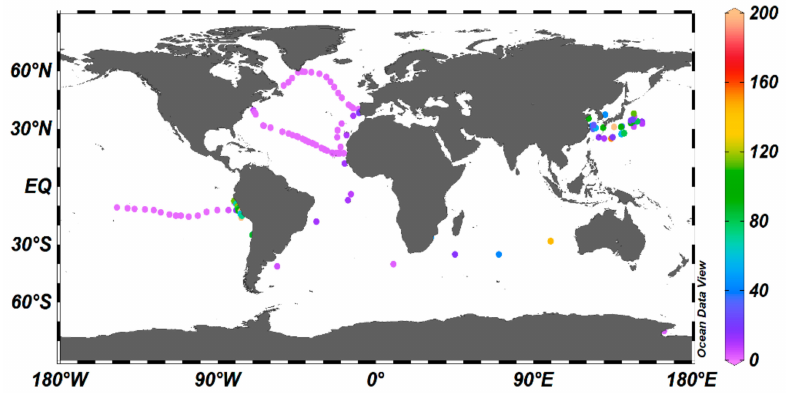
Figure 6. Global distributions of dissolved aerosol Cu over the global oceans. The color bar refers to the concentration of dissolved aerosol Cu in the unit of pmol m − 3 .Data sources: Maenhaut and Cafmeyer [177], Virkkula et al. [178], Witt et al. [179], Chand et al. [180], Hsu et al. [169], Kang et al. [181], Laing et al. [182], Chance et al. [183], Illuminati et al. [184], Baker et al. [185], Wang et al. [28],